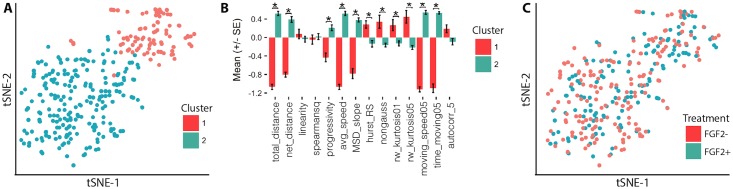
Myoblasts display distinct motility states, shared by both FGF2+ and FGF- conditions.(A) t-SNE visualization of hierarchical clusters in myoblast motility space (perplexity = 30) (MANOVA, p < 0.001; Silhouette Si = 0.31). (B) Normalized feature means for motility state clusters (*: p < 0.05, Holm-Bonferroni corrected t-test). (C) t-SNE visualization of FGF2 treated (blue) and untreated (red) myoblasts in motility space. n ≈ 150 cells per condition, taken from two separate animals, with total n = 308 cells.